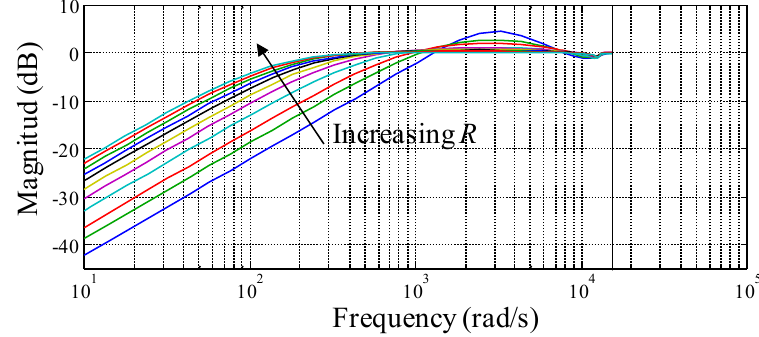
Figure 7. Bode magnitude diagram of S operating